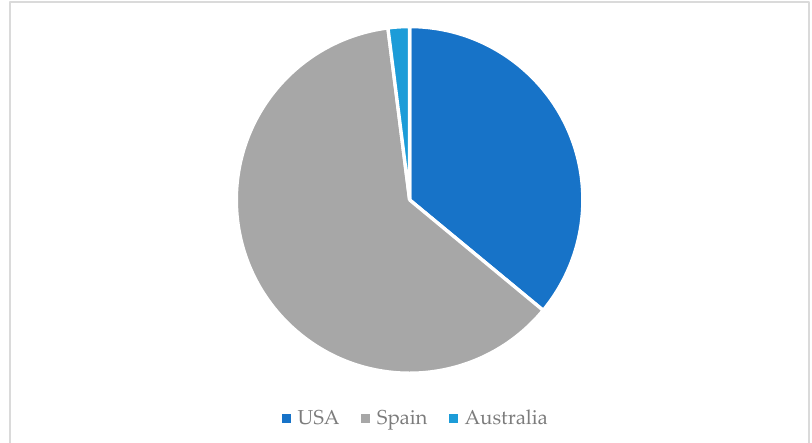
Figure 3. Geographical distribution.